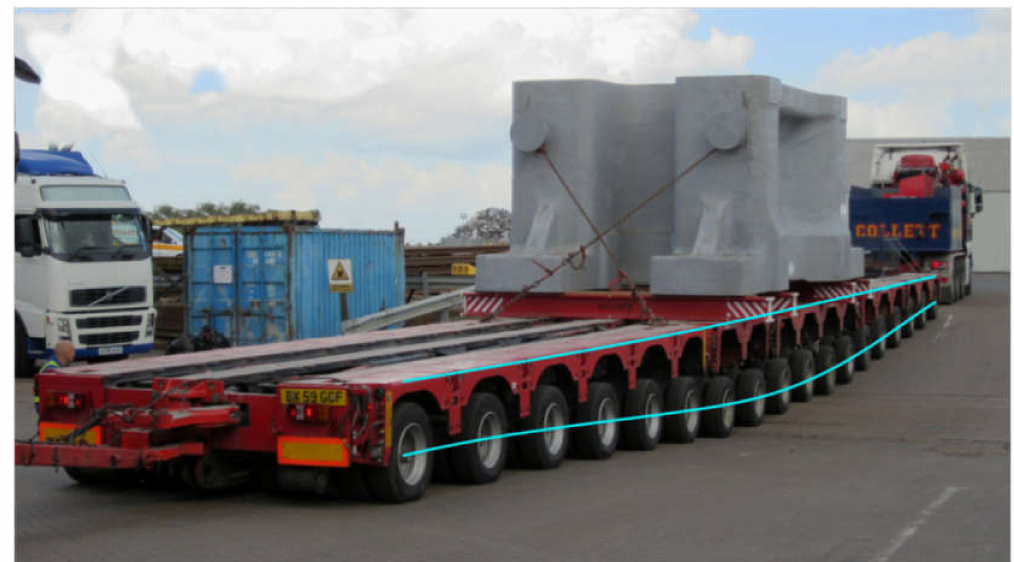
Figure 1. Modular trailer axle compensation [28].